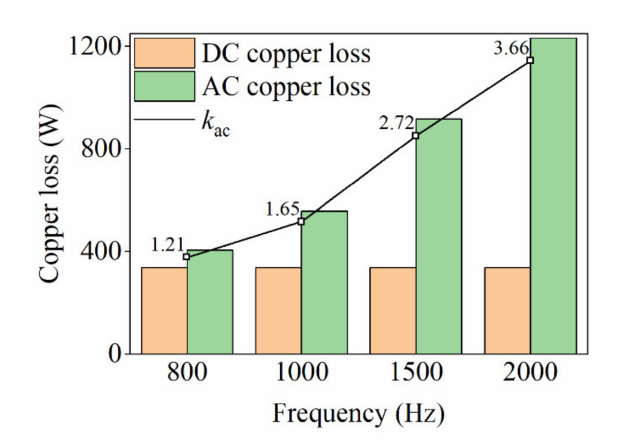
Figure 5. Copper loss and AC/DC copper loss ratio k ac with frequency.